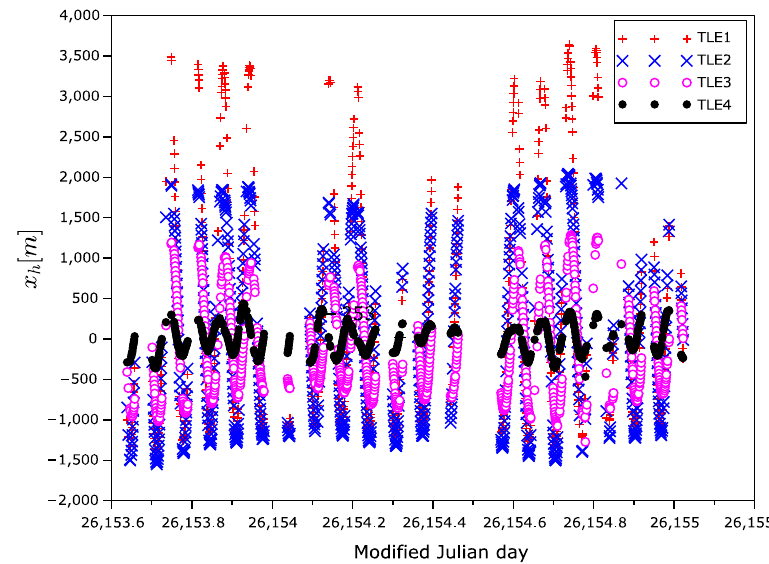
Figure 7. 𝑥 (cid:3035) position error as a function of time in Hill frame.